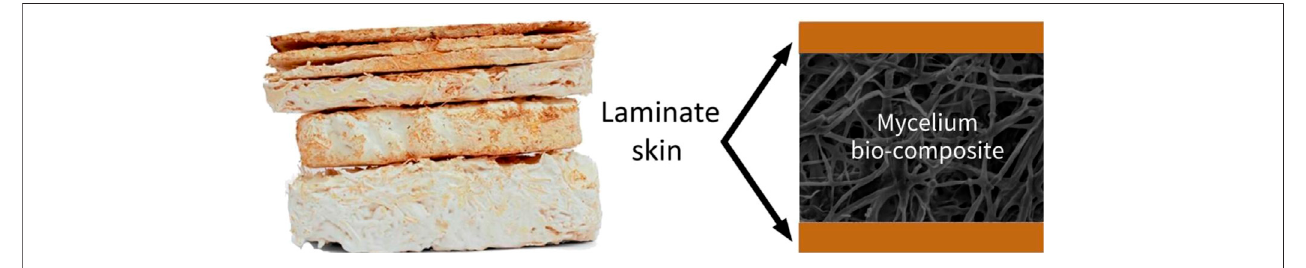
FIGURE 2 | A snapshot of the MBF (left) (Karana et al., 2018) (reused under a creative commons attribution license) and a schematic of the MBSC (right) .